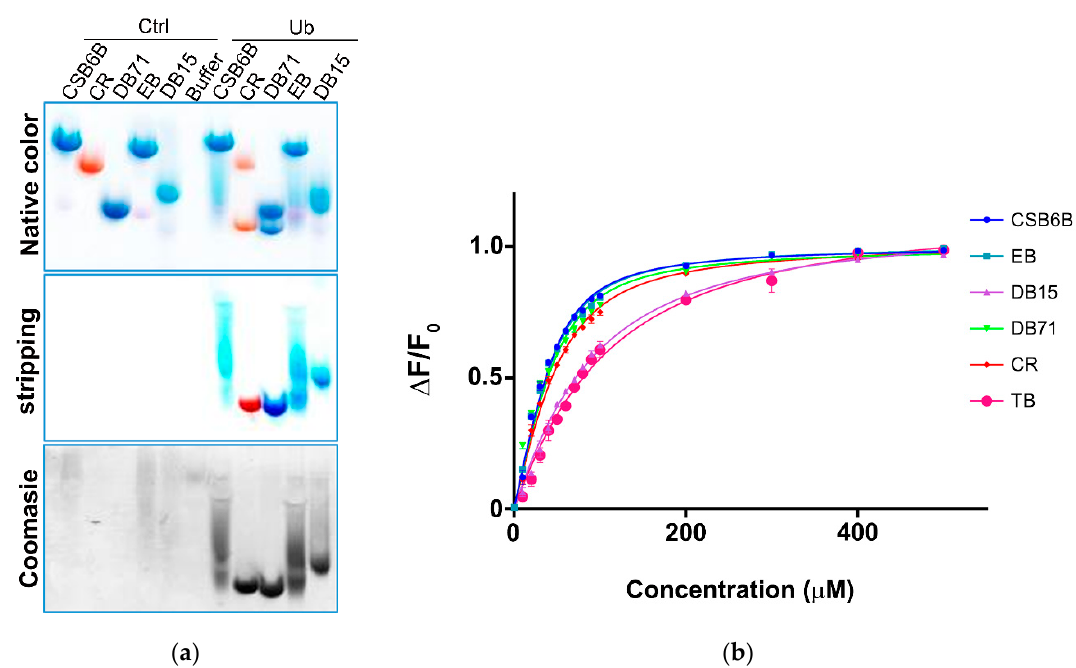
Figure 2. Binding of sulfonated aryl diazo compounds to ubiquitin. ( a ) Visualization of compounds alone (Ctrl) and bound to ubiquitin (Ub) in native-PAGE before (top, native color) and after (middle, stripping) stripping with de-staining solution. Protein bands were stained by Coomassie blue (bottom). ( b ) Intrinsic fluorescence anisotropy of ubiquitin upon treatment with various CSB6B analogs.